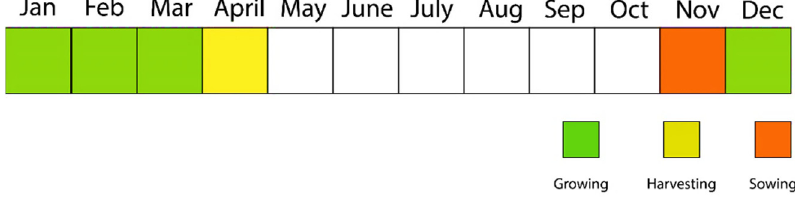
Figure 2. Cropping calendar of wheat in Punjab, Pakistan.